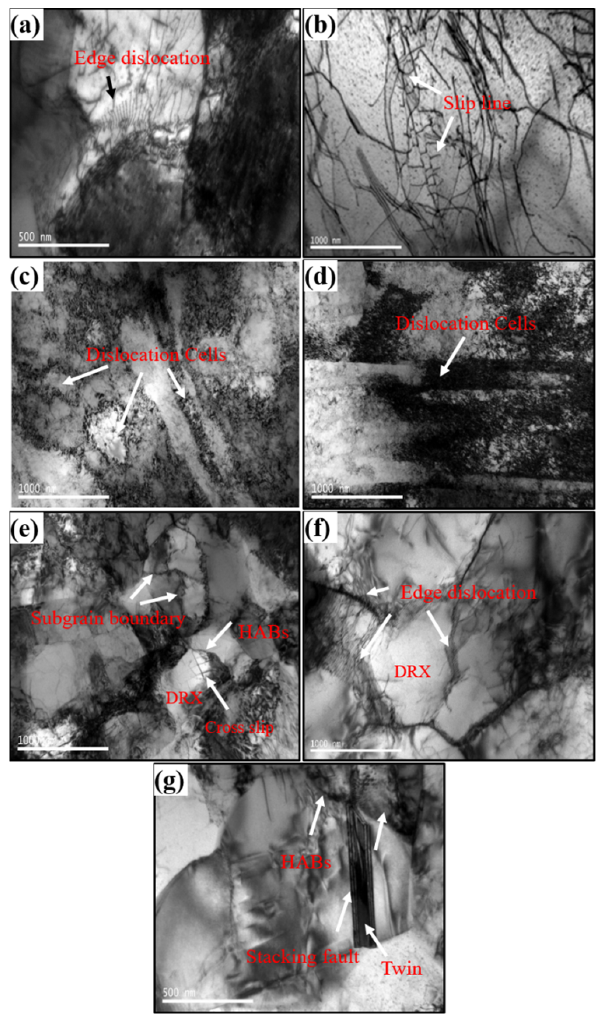
Figure 9. TEM pictures of the Cu-Sn-P alloy at different temperatures: ( a , b ) 200 °C, ( c , d ) 300 °C, ( e ) 400 °C, and ( f , g ) 500 °C.